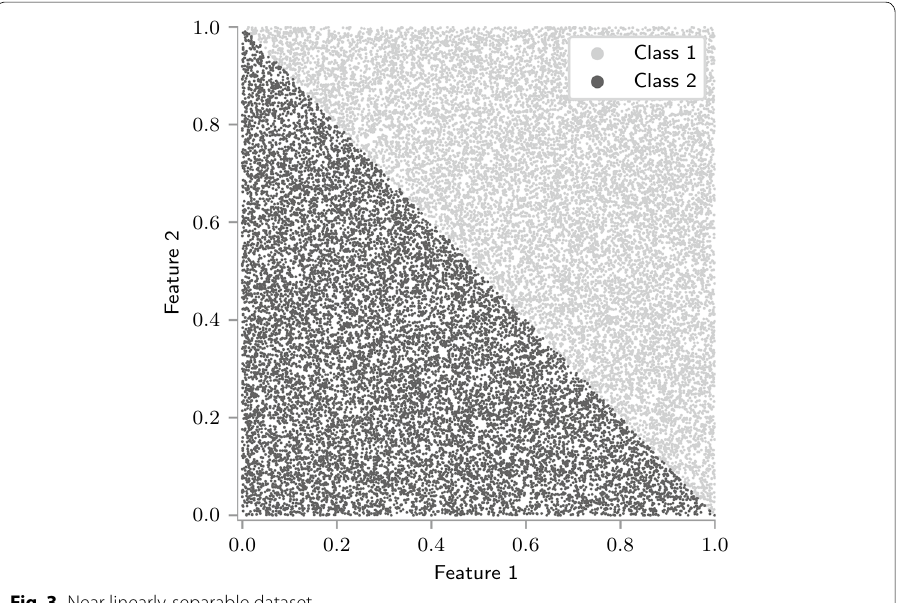
Fig. 3 Near linearly-separable